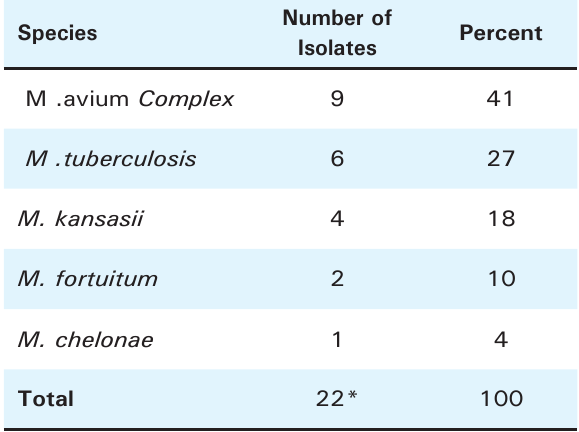
Table 3. Identi fi cation of Mycobacterium Species